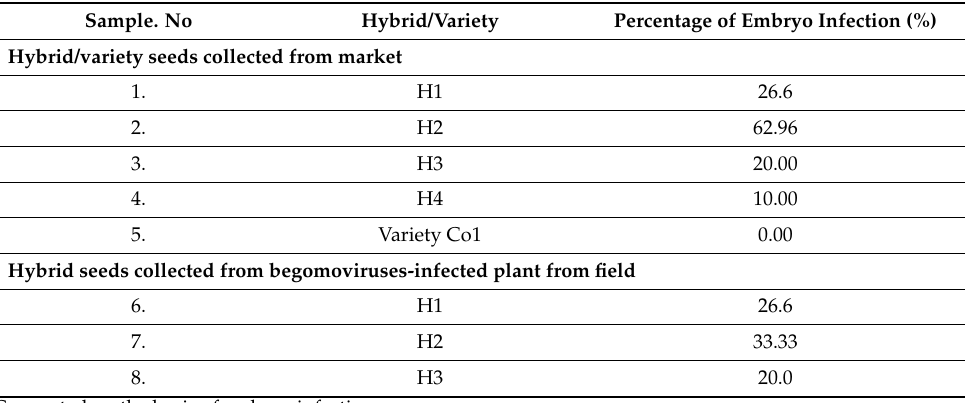
Figure 1. ( A ) Different parts of seeds dissected for DAS-ELISA; a. Seed coat, b. Endosperm. Figure 1. ( A ) Di ff erent parts of seeds dissected for DAS-ELISA; a. Seed coat, b. Endo- c. Embryo. ( B ) Detection of ToLCNDV in DAS-ELISA-positive embryo samples of H2 seeds from sperm. c. Embryo. ( B ) Detection of ToLCNDV in DAS-ELISA-positive embryo samples market; Lane-M—1 Kb Ladder, L1–L16—H2 Embryo samples, Lane M—1 Kb Ladder, L17, 18—H2 of H2 seeds from market; Lane-M—1 Kb Ladder, L1–L16—H2 Embryo samples, Lane Embryo samples; L16, 19—PC. M—1 Kb Ladder, L17, 18—H2 Embryo samples; L16, 19—PC. Table 1. Summary of DAS-ELISA results for different bitter gourd Table 1. Summary of DAS - ELISA results for di ff erent bi tt er gourd seeds.